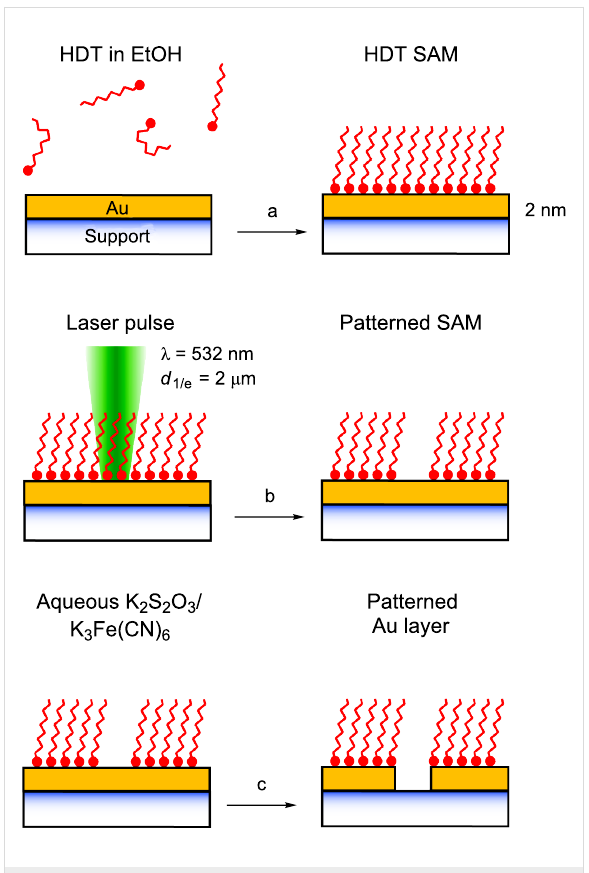
Figure 1: Schematic diagram of the process flow: (a) SAM formation upon immersion in an ethanolic solution of HDT; (b) photothermal laser processing of the HDT SAM at λ = 532 nm; and (c) pattern transfer into the Au film upon etching in an aqueous solution of K 2 S 2 O 3 and K 3 Fe(CN) 6 . Adapted from